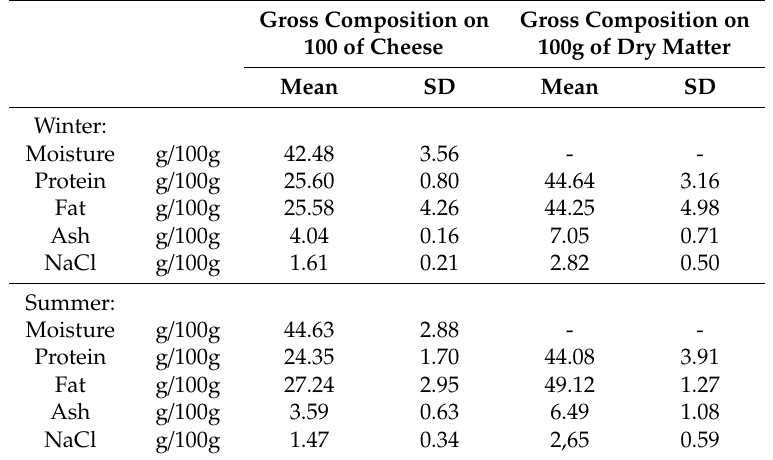
Table 1. Average gross composition of Formaggella della Valle di Scalve cheese at 30 days’ ripening produced during the winter and summer periods. Gross Composition on Gross Composition 100 of Cheese